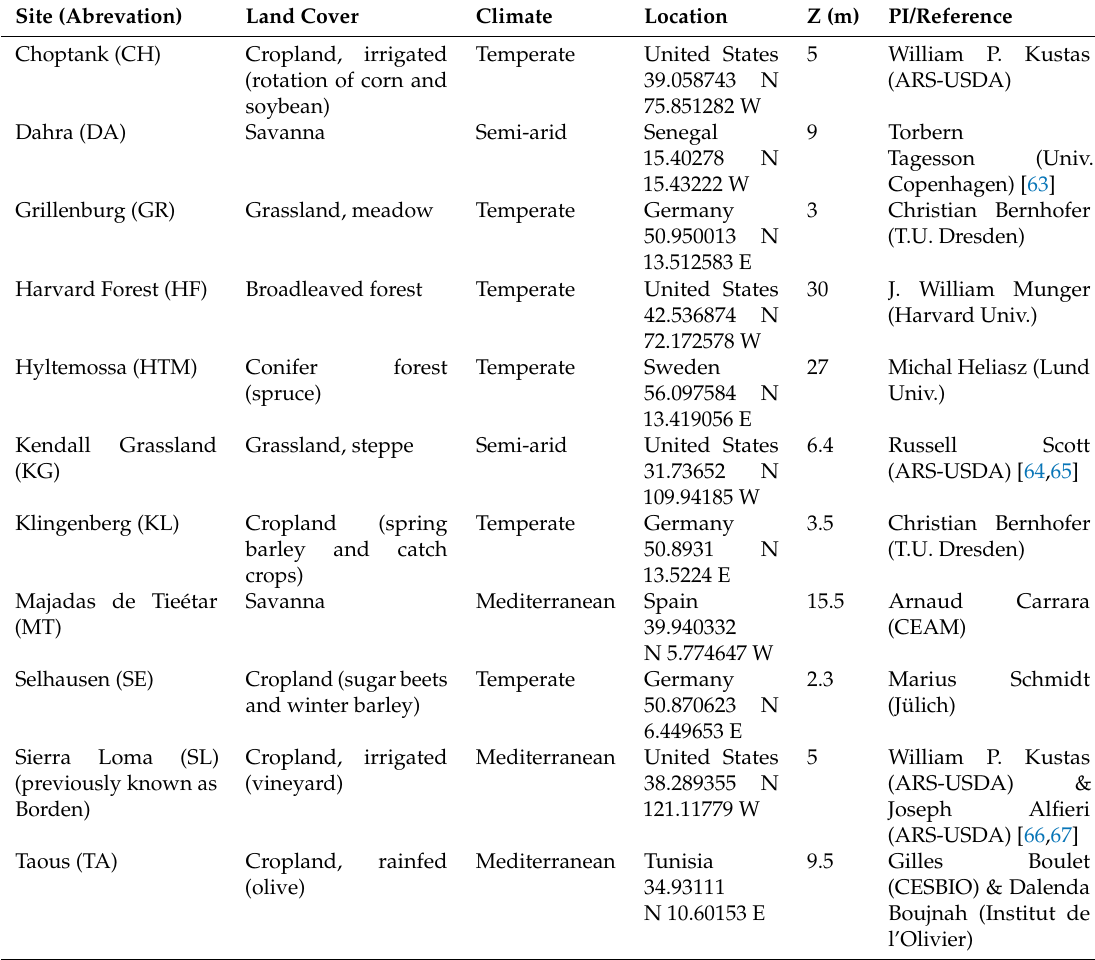
Table 1. Description of eddy covariance sites used for validation. Sites are listed in alphabetic order. Z shows the EC measurement height in meters, while the contact person for the EC tower is credited in PI